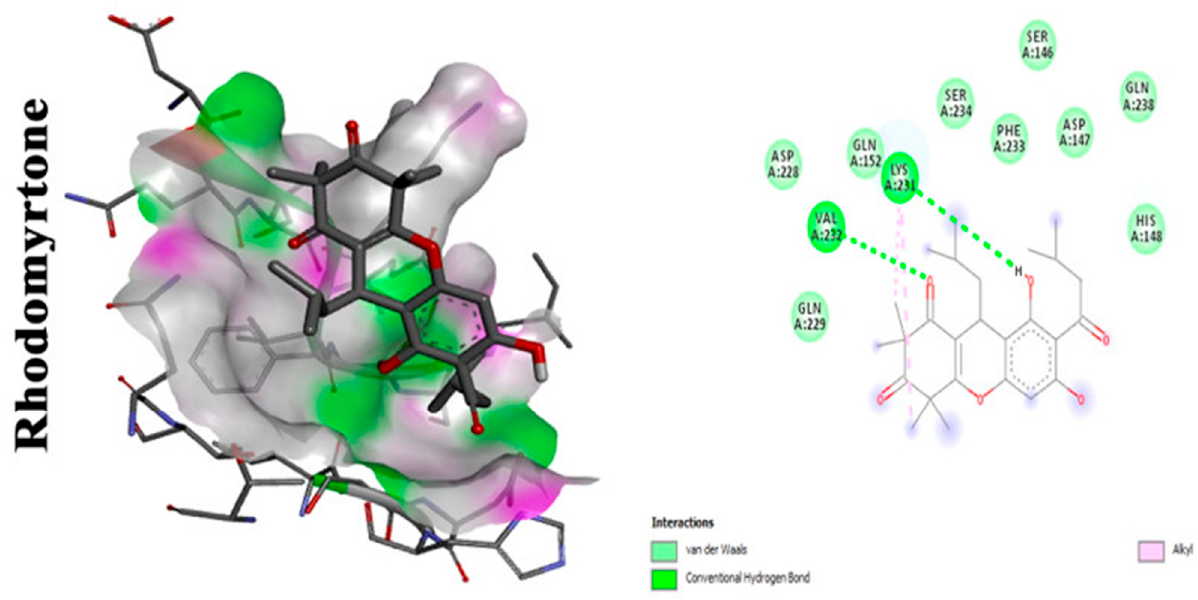
Figure 2. Molecular docking analysis showing (two-dimensional) 2D and (three-dimensional) 3D representation of interaction patterns of rhodomyrtone with CrtM receptor [25].